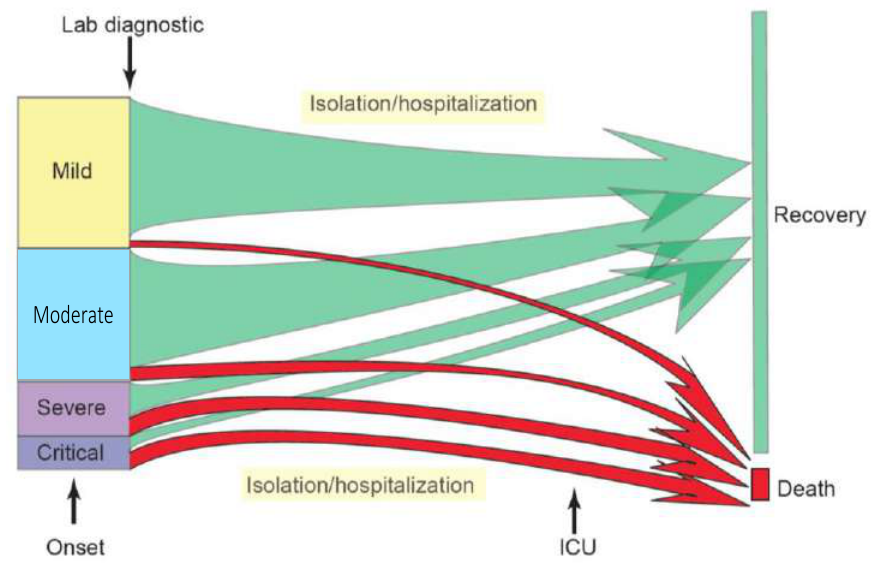
Figure 5. Pattern of disease progression for COVID-19 in China Note: the relative size of the boxes for disease severity and outcome reflect the proportion of cases reported as of 20 February 2020. The size of the arrows indicates the proportion of cases who recovered or died. Disease definitions are described above. Moderate cases have a mild form of